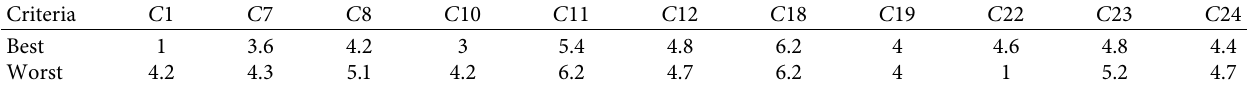
Table 5: Pairwise comparisons of the best and worst criteria based on the opinions of key experts.